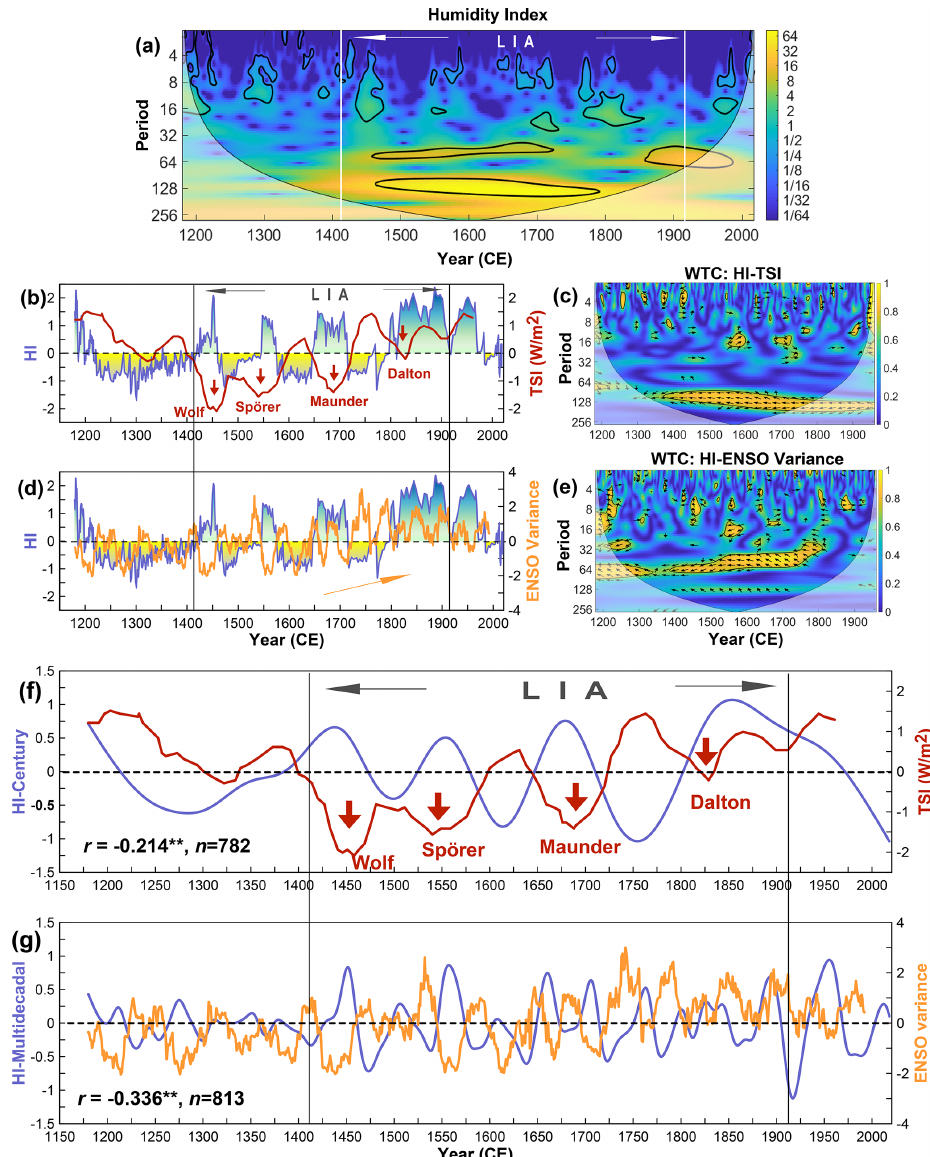
Figure 7. The wavelet analysis of the HI and the relationship between the HI and the TSI or ENSO. (a) Continuous wavelet (CWT) power spectrum of the HI. The irregular thick black contour represents the 95% confidence level against red noise, and the thin curved black solid line is the cone of influence (COI) (Grinsted et al., 2004). (b) A comparison between the HI and the reconstructed total solar irradiance (TSI) (Bard et al., 2000). Wolf, Spörer, Maunder, and Dalton represent several grand solar minimums that occurred during the LIA. (c) The wavelet coherence (WTC) result between the HI and the TSI (Bard et al., 2000). (d) As (b) , but for ENSO variance reconstruction (Li et al., 2011). Orange arrows represent the enhanced ENSO amplitude trend. (e) As (c) , but for ENSO variance (Li et al., 2011). (f) A comparison between the century component of HI and TSI (Bard et al., 2000). (g) A comparison between the multidecadal component of the HI and ENSO variance reconstruction (Li et al., 2011). The 95% confidence level against red noise is shown as an irregular thick black contour. The black arrows illustrate the relative phase relationship: arrows pointing right are in phase and those pointing left are anti-phase (Grinsted et al., 2004). Two asterisks (**) represent the 0.01 significance